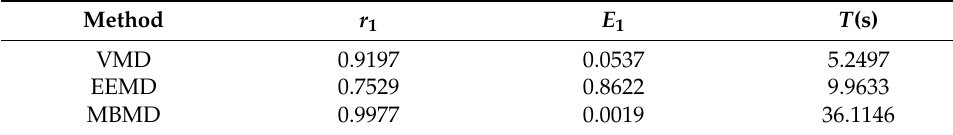
Table 2. Evaluation parameters of the three algorithms (SNR 10).